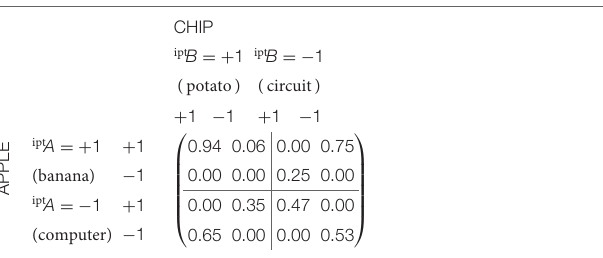
TABLE 1 | Pair-wise joint distributions of conceptual combination “APPLE CHIP” (Bruza et al.,